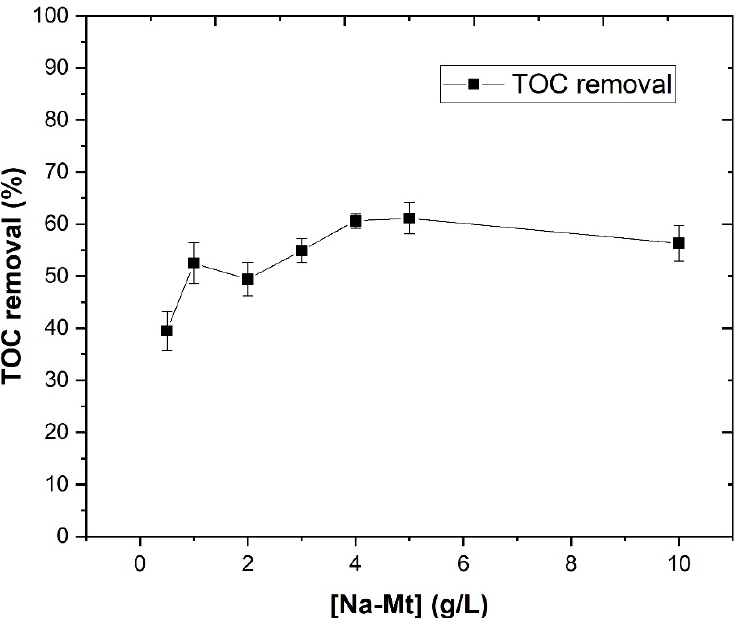
Figure 4. Effect of Na-Mt dosage variation (0.5–10.0 g/L) in adsorption of organic matter from WW onto Na-Mt, under the following operational conditions: pH = 3.0, V = 500 mL, agitation 350 rpm, T = 298 K, t = 24 h.